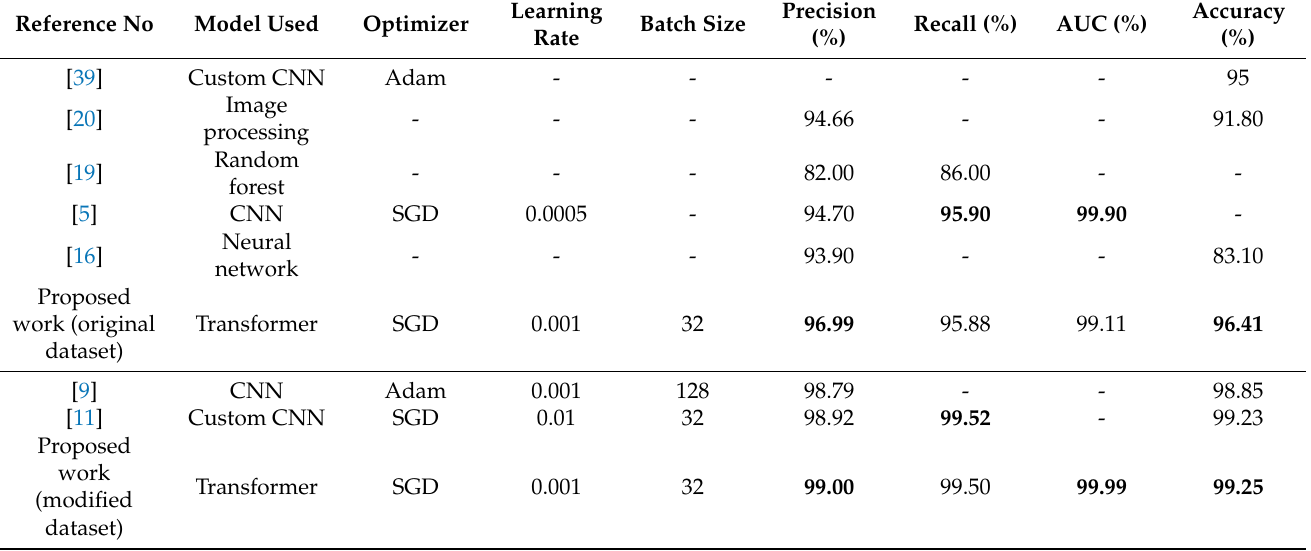
Table 6. Performance comparison with previous